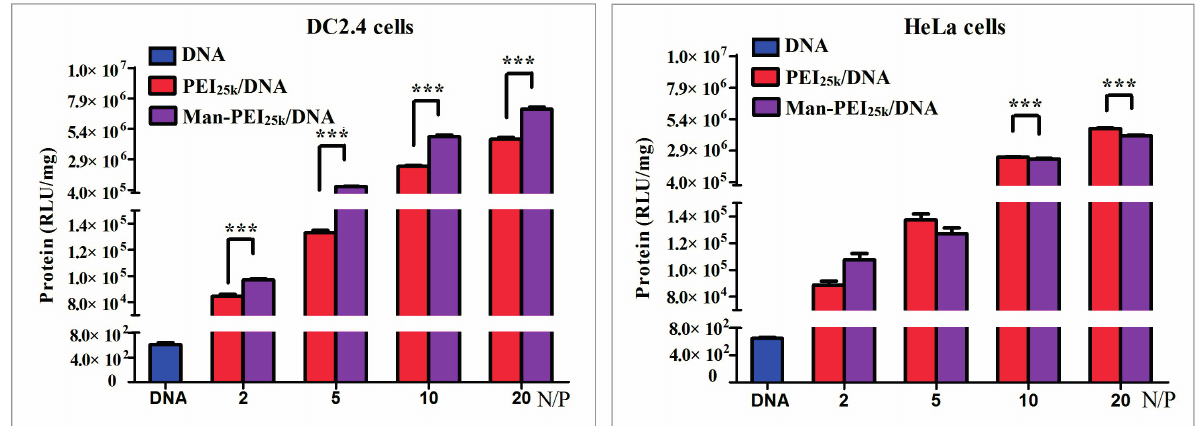
Figure 7. Transfection efficiencies of the PEI/DNA complexes with various N/P ratios in the two different cell lines. Each data point represents the mean ± standard deviation ( n = 6). *** p <